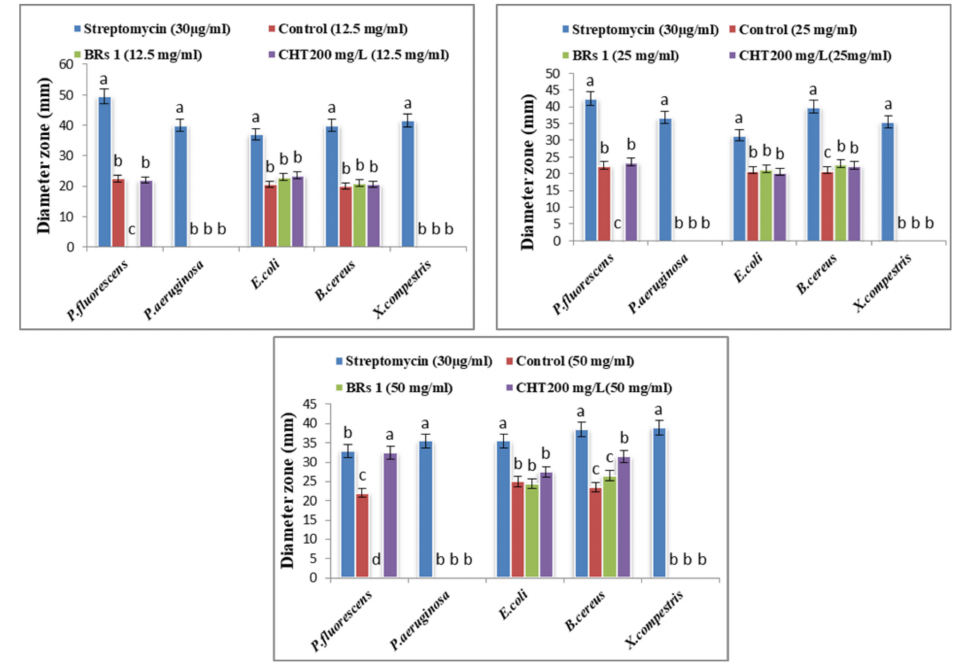
Figure 1. E ff ect of control, BRs (1) at 10 − 8 M and CHT 200 mg / L on bacterial activity of Solidago canadensis cv. Tara plant. Columns data with di ff erent letter / s di ff er significantly ( p ≤ 0.05). letters (a–c) are comparison of individual treatment